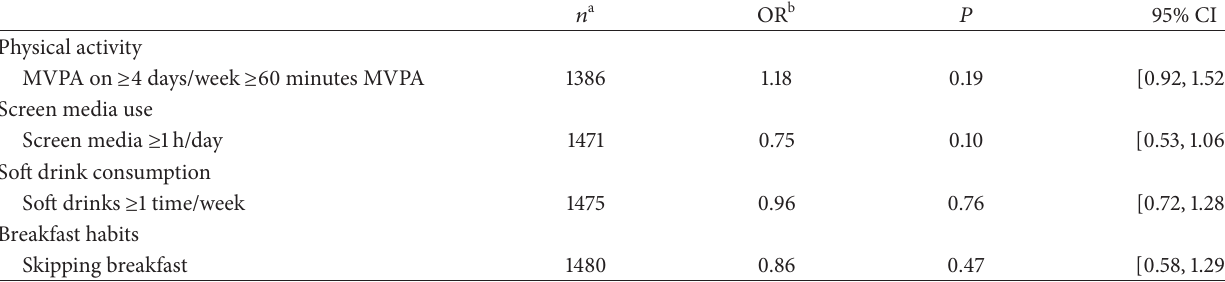
Table 3: Behavioural outcomes at follow-up for the intervention